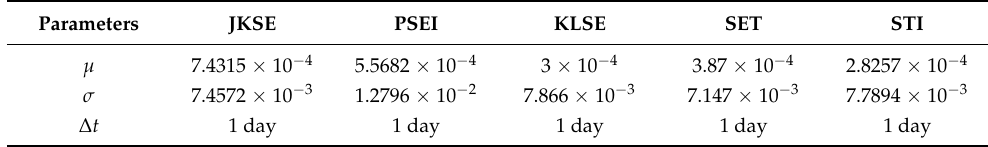
Table 5. GBM model